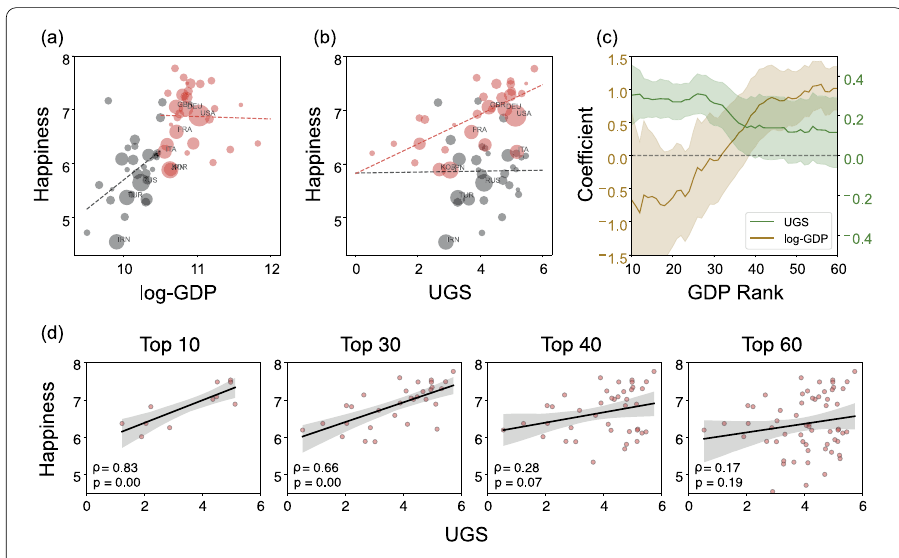
Figure 2 The effect of GDP on the green-happiness relation. ( a ), ( b ) The relations of ( a ) log-GDP and happiness, and ( b ) urban green space (i.e., UGS) and happiness across 60 developed countries. The top 30 and the lower 30 countries ranked by GDP are sized by the population size and colored by red and black. The dotted lines are the linear fit for each GDP group. ( c ) Changes of coefficients between urban green space and happiness for different sets of GDP rank with increasing window size from top 10 to 60. ( d ) The rank correlations between the UGS and happiness for the groups of increasing countries in the GDP rank